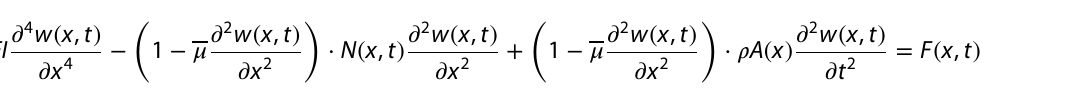
Fig. 3 Nanobeam probe with spring-mass approaching sample of interest a sample in open air, b stubby probe in viscous fluid